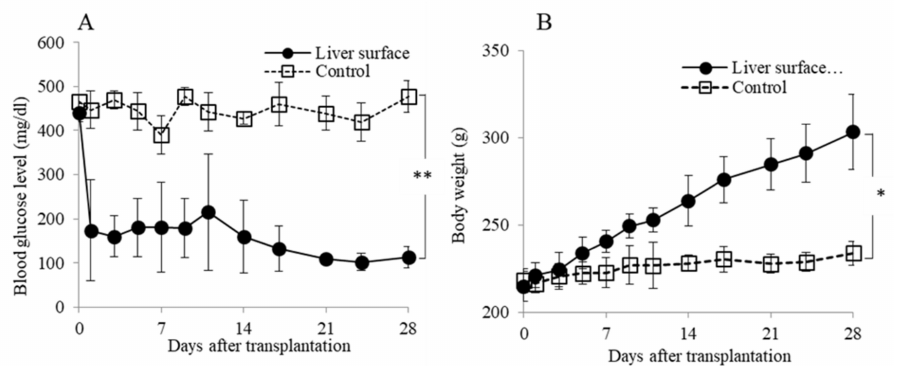
Figure 3. Metabolic evolution after islet transplantation. ( A ) The changes in the blood glucose levels after islet transplan- tation and ( B ) the changes in body weight after islet transplantation. The liver surface transplantation with keratinocyte sheet (cell sheet group; black circle, n = 4) showed significantly better blood glucose levels than without keratinocyte sheet (control group; white square, n = 4). Data are mean ± SEM (** p < 0.01, * p < 0.05,